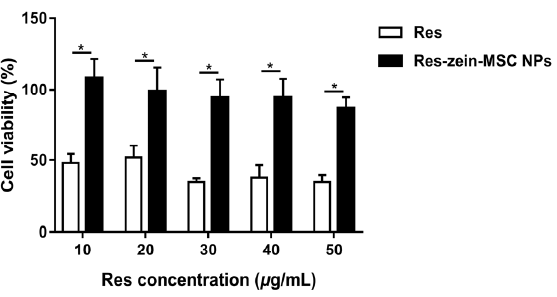
Figure 5. The cell viabilities of RAW 264.7 cells after treating with Res and Res-zein-MSC NPs. Here, * represents a significant difference between samples ( p < 0.05).